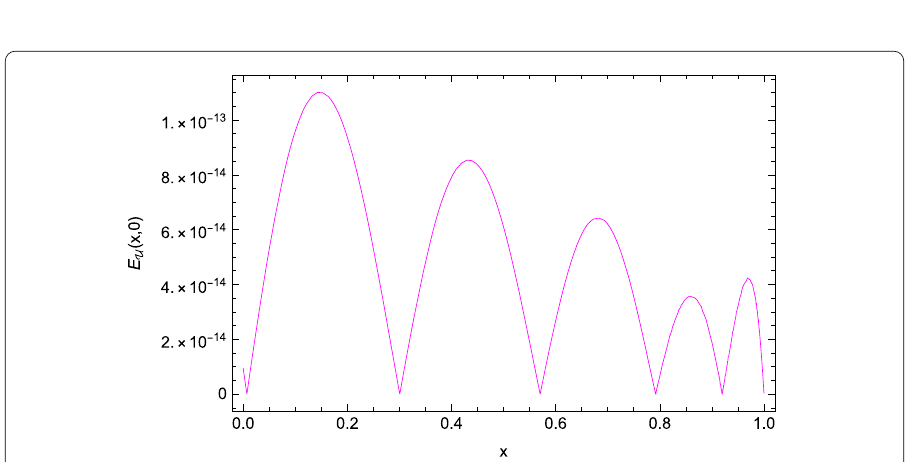
Figure 10 E U ( x ,0) of problem of problem (3), where δ = 1.8, N = 10, M = 2